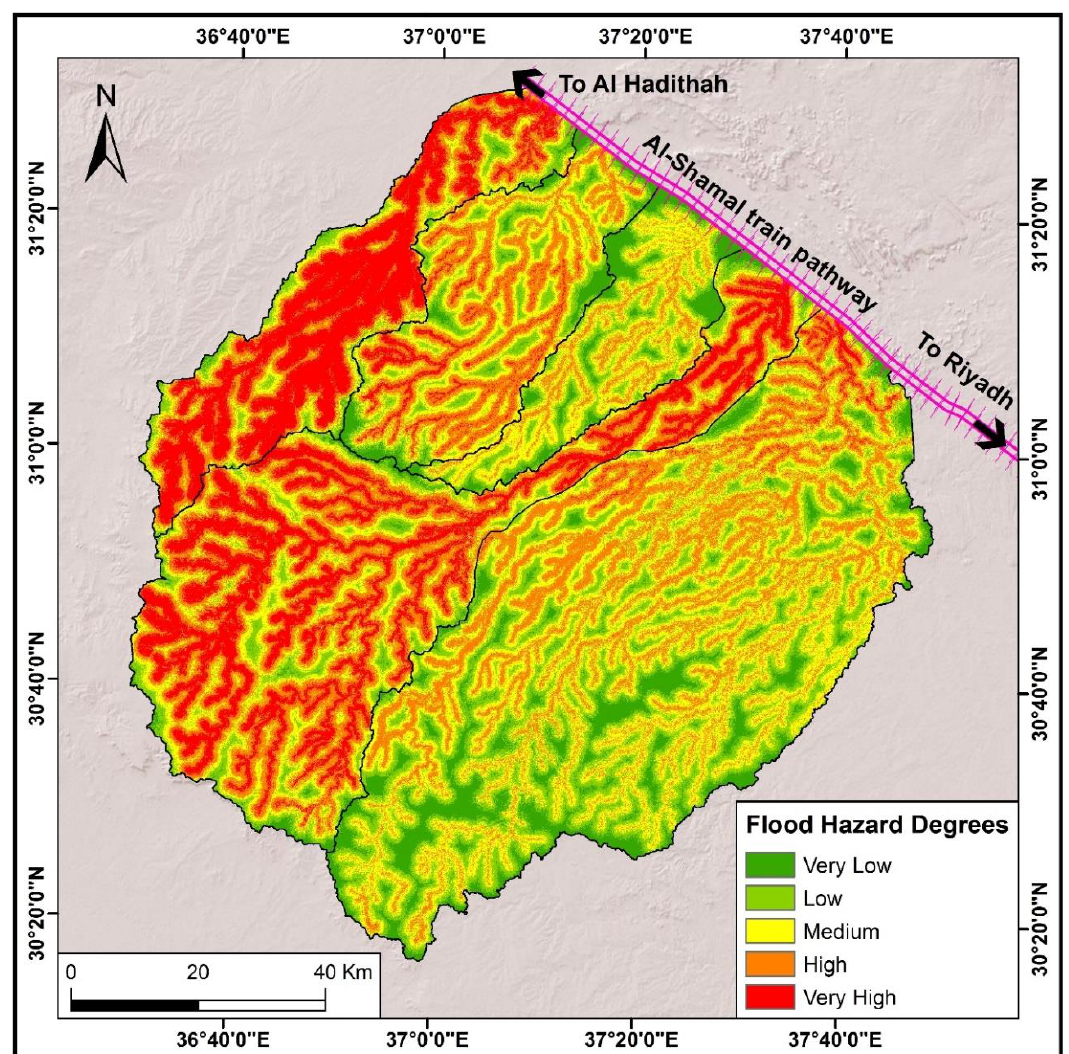
Table 19. Degrees of flood hazard in the study area in 2020.